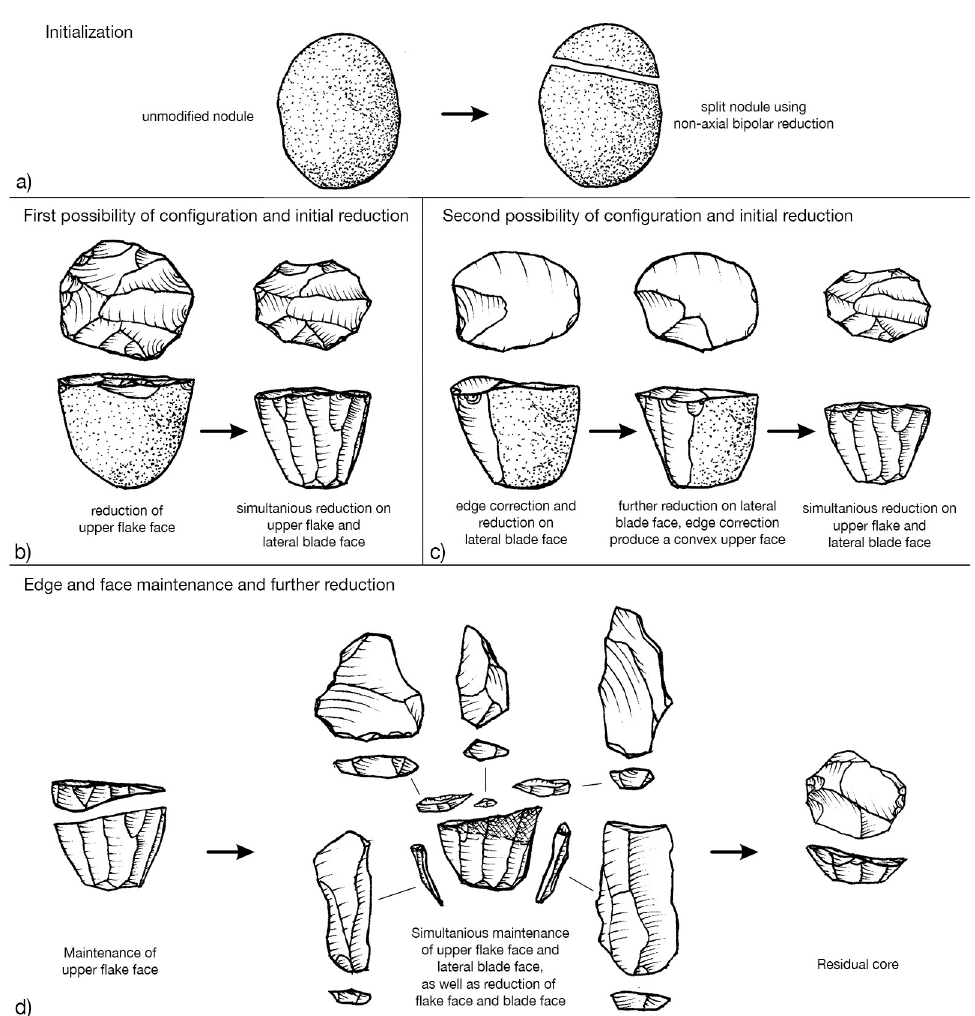
Fig 10. Reconstructed (almost) non-branched reduction sequence. Legend: Reconstructed nearly homothetic reduction on truncated cone-shaped core. Drawings by H. Wu¨rschem.